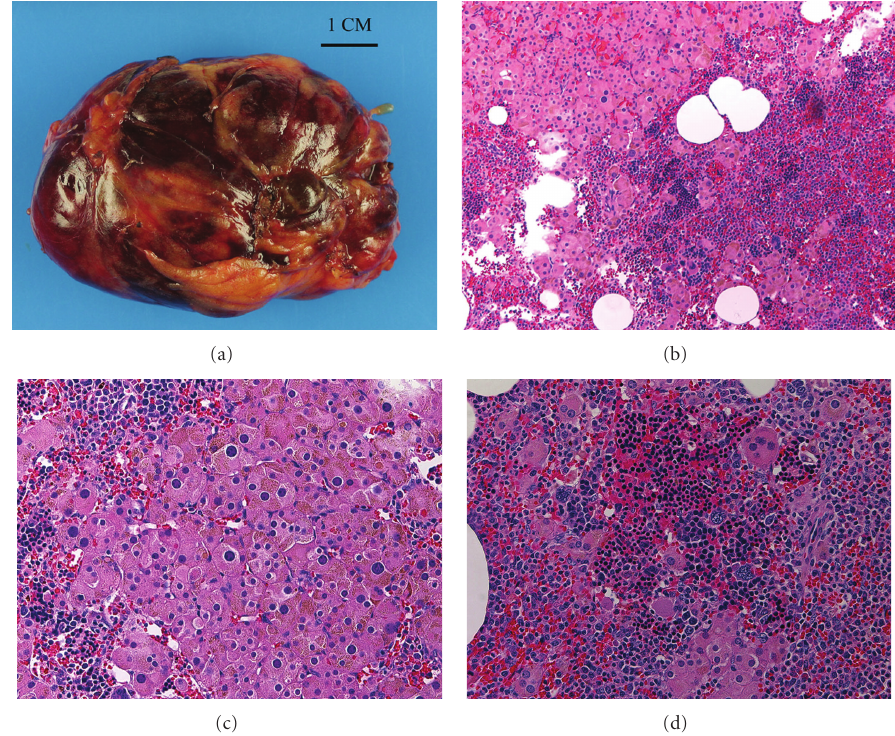
Figure 2: Gross examination of the retroperitoneal mass showed a red-tan smooth-surfaced lobulated mass with areas of fat (a). Microscopic examination showed oncocytes, adipocytes, and trilineage hematopoeisis intimately associated ((b), H&E, 100x). The oncocytes had abundant granular cytoplasm with lipofuscin. Random nuclear atypia is readily apparent but no mitotic activity was identified ((c), H&E, 200x). The oncocytes were interspersed with maturing erythroids and myeloid elements and megakaryocytes ((d), H&E,